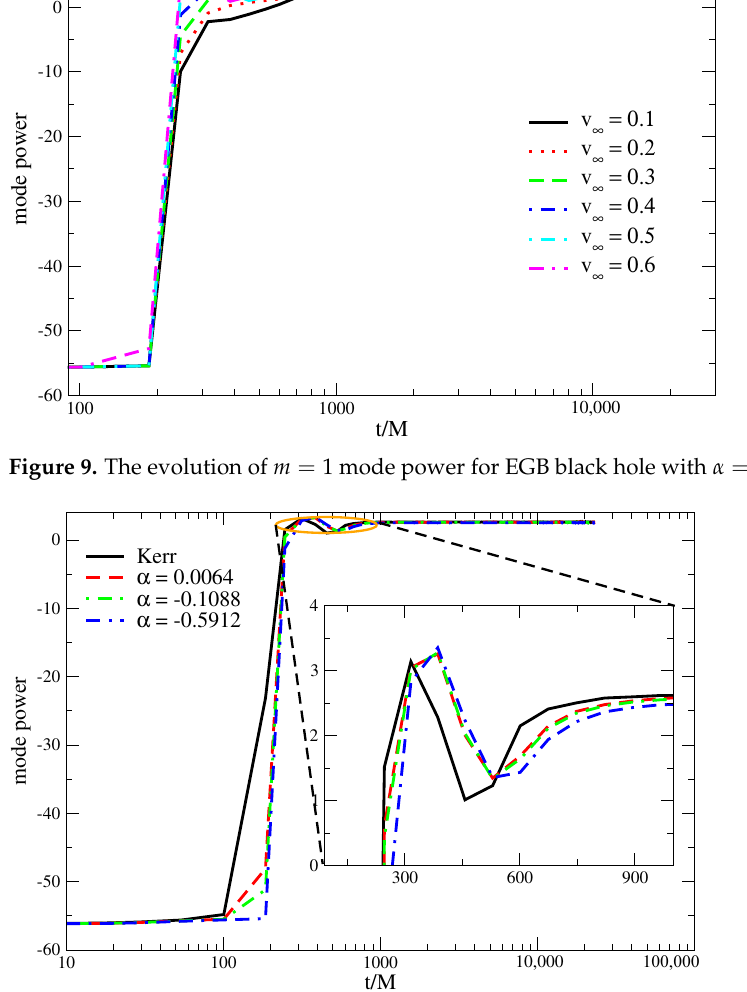
Figure 10. The evolution of m = 1 mode power for Kerr and EGB black holes with V ∞ =